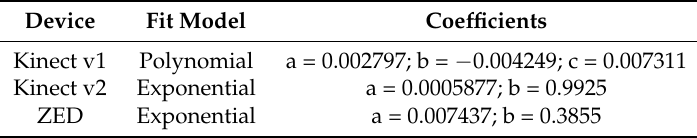
Table 3. Coefficients for best fit